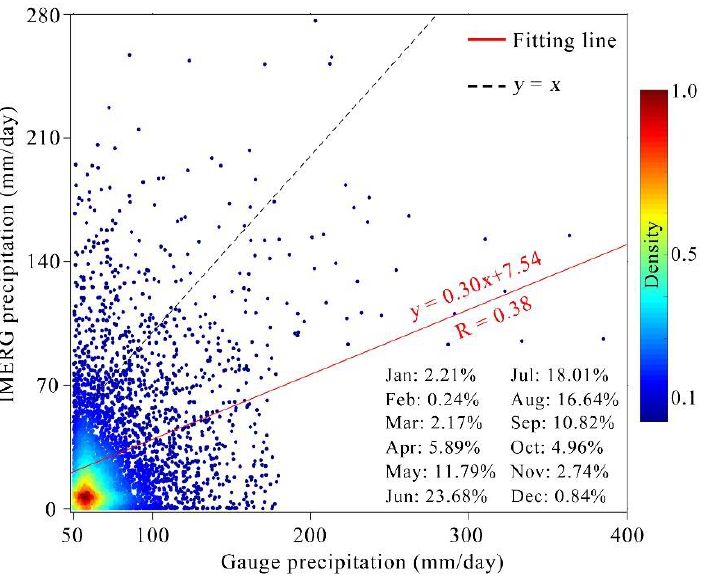
Figure 2. Precipitation scatter plot of rain gauge data and Integrated Multi-satellite Retrievals for Global Precipitation Measurement (GPM) (IMERG) late run (LR). Global Precipitation Measurement (GPM) (IMERG) late run (LR).